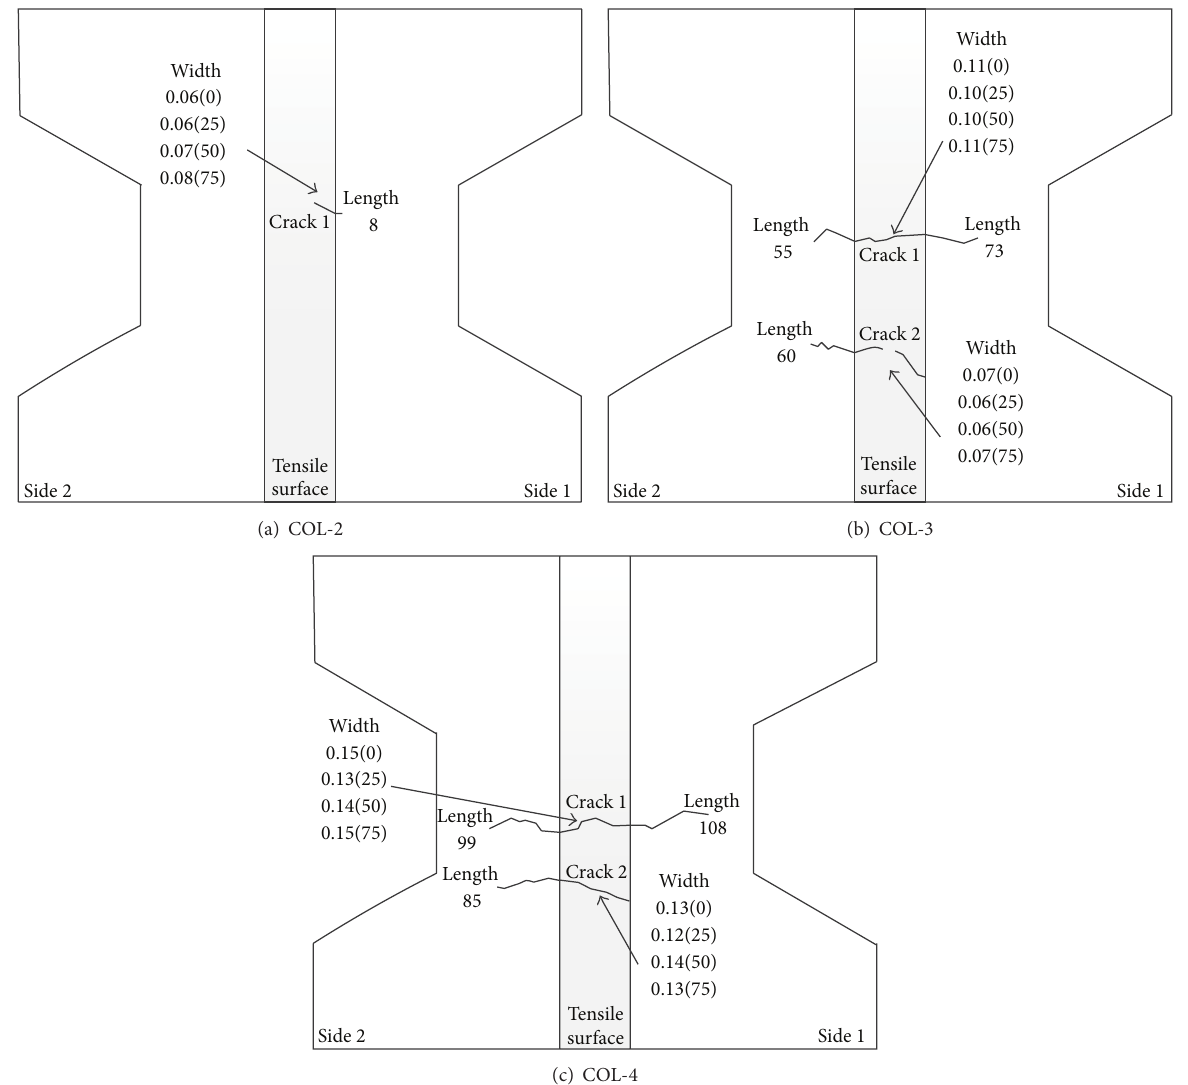
Figure 6: Distribution and development of cracks in COL-2 ∼ COL-4 after a specified number of series of cyclic exposure.